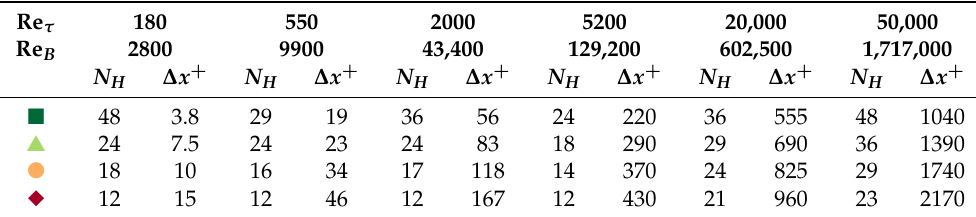
Table 1. Summary of the investigated grids and Reynolds numbers as well as their color codes used in the following mean velocity plots. N H denoting the number of discrete nodes per channel half height and (rounded) Re B data correspond to Dean’s correlation (Re B ≈ 7.32Re 8/7 τ ). Furthermore, the resulting non-dimensional grid spacings ∆ x + ( Re τ , N H ) are